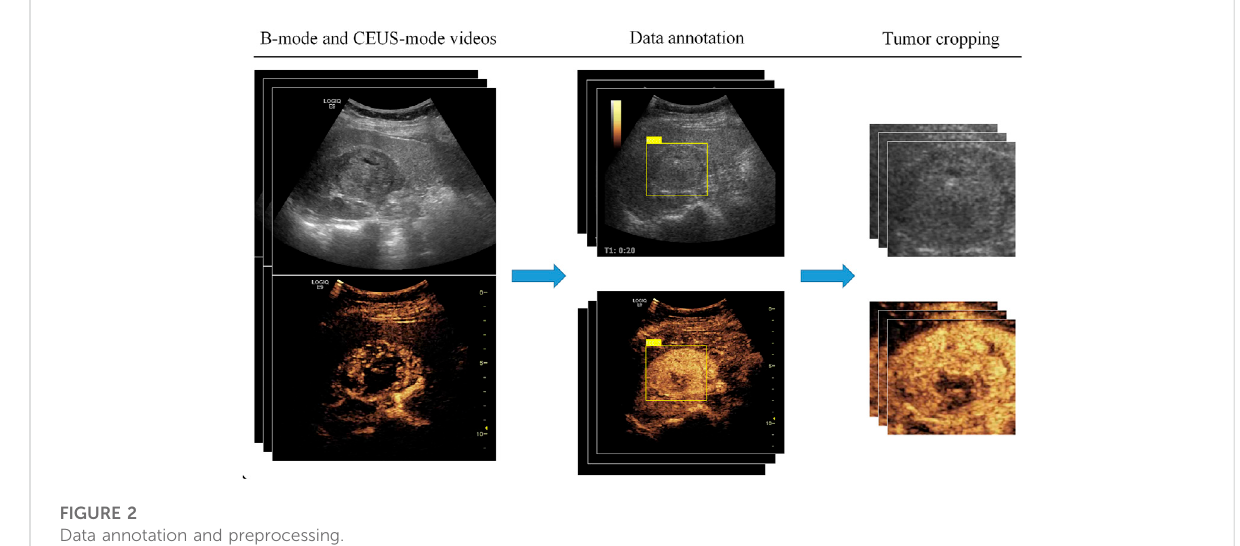
FIGURE 2 Data annotation and preprocessing.